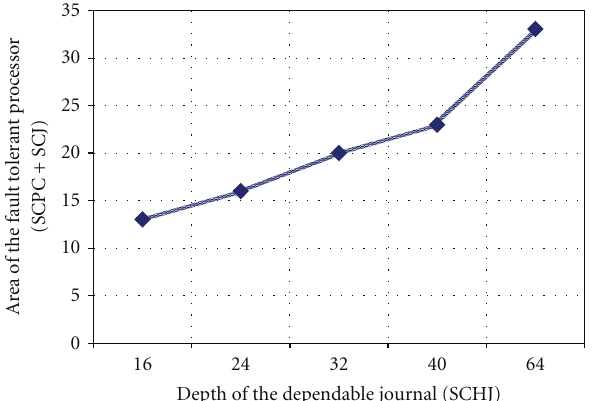
Figure 17: SCHJ/SCPC area ratio to SCHJ depth.